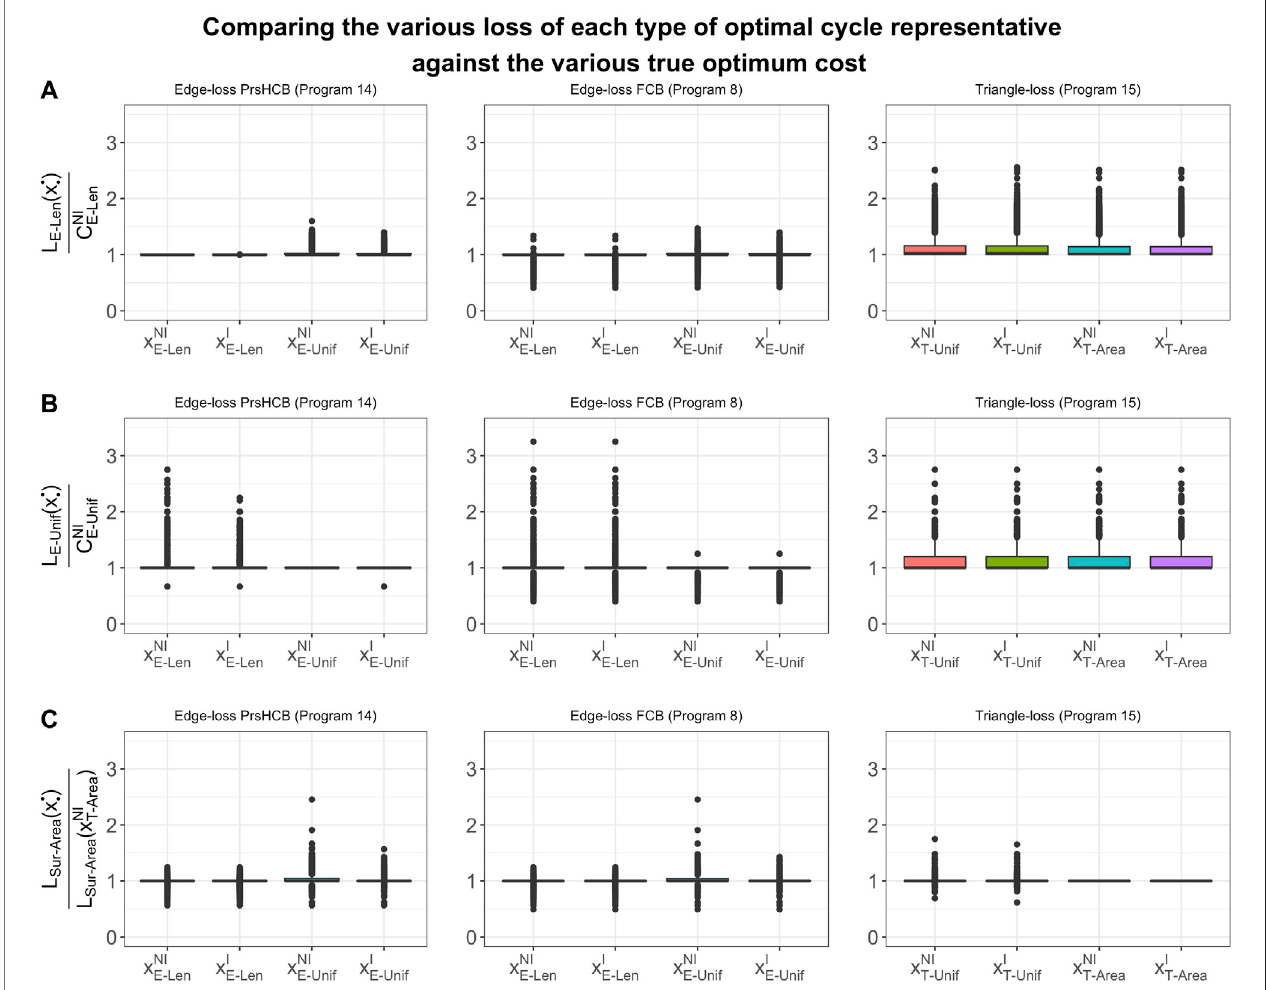
FIGURE 8 | Box plots of the ratios between (A) L E - Len ( x p (cid:129) ) and C NI E - Len (B) L E - Unif ( x p (cid:129) ) and C NI E - Unif , and (C) L Sur - Area ( x p (cid:129) ) and L Sur - Area ( x NI T - Area ) . Within each row, the denominator is fi xed across all three columns, and corresponds to the PrsHCB cycles which are solutions to Programs Edge NI Unif row (A) , Edge NI Len row (B) , or Tri NI Area row (C) .Thehorizontalaxisofeachsubplotisthetypeofoptimalrepresentative.Thecostoftheoptimalsolutionstotheprogramsin Eqs8 , 14 ,andProgramTri NI Area wasequal regardlessofthepresenceofanintegerconstraintinnearlyallexamples(asdiscussedin Section6.3 ),resultingintwocolumnsineachrowhavingratio1.Thedata used in (A) and (B) aggregate over all cycle representatives from data described in Sections 5.1 and 5.2 . The data used in (C) aggregate the 746 cycle representatives from 40 point clouds with ambient dimension of two from data described in Section 5.2 . We observe that some edge-loss and uniform-weighted-triangle-loss optimal cycleshaveasurveyor ’ sareastrictlysmallerthan thedenominatorinrow (C) ;referto Figure8 and Section6.4 toseewhythismayhappen. Itispossible for L E - Unif ( x p (cid:129) ) tobestrictlysmallerthan C